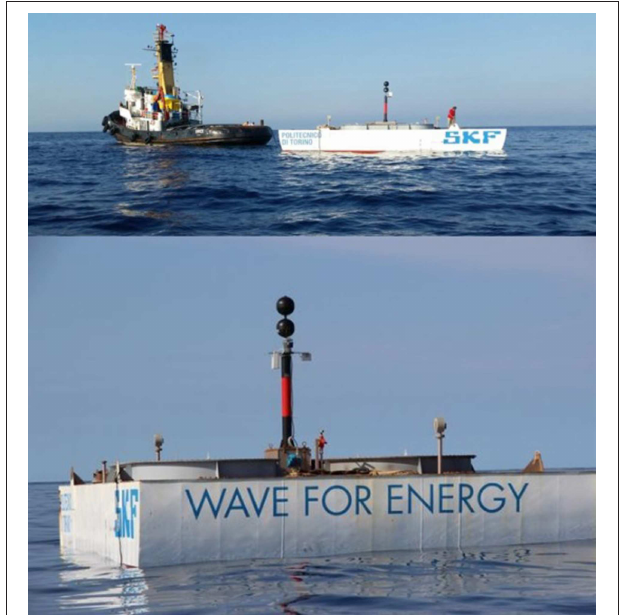
FIGURE 14 | Transportation of ISWEC to the installation site in Pantelleria. August 2015 (Top) and ISWEC deployed at sea (Bottom) .